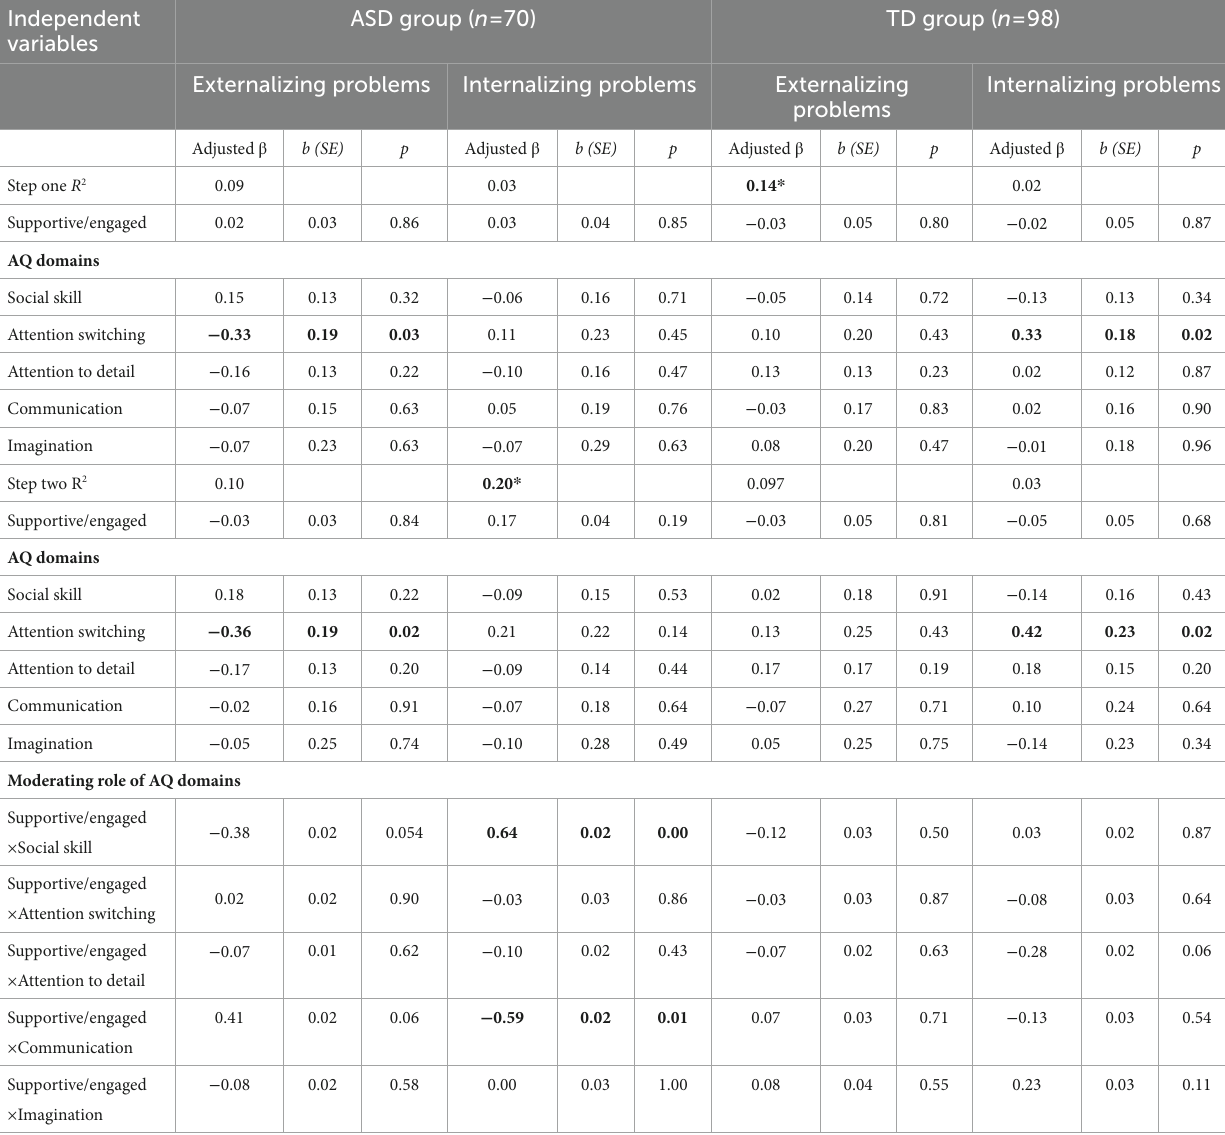
TABLE 3 Moderated multiple regression model of the supportive/engaged parenting behavior on behavior problems in children with ASD and TD. Independent